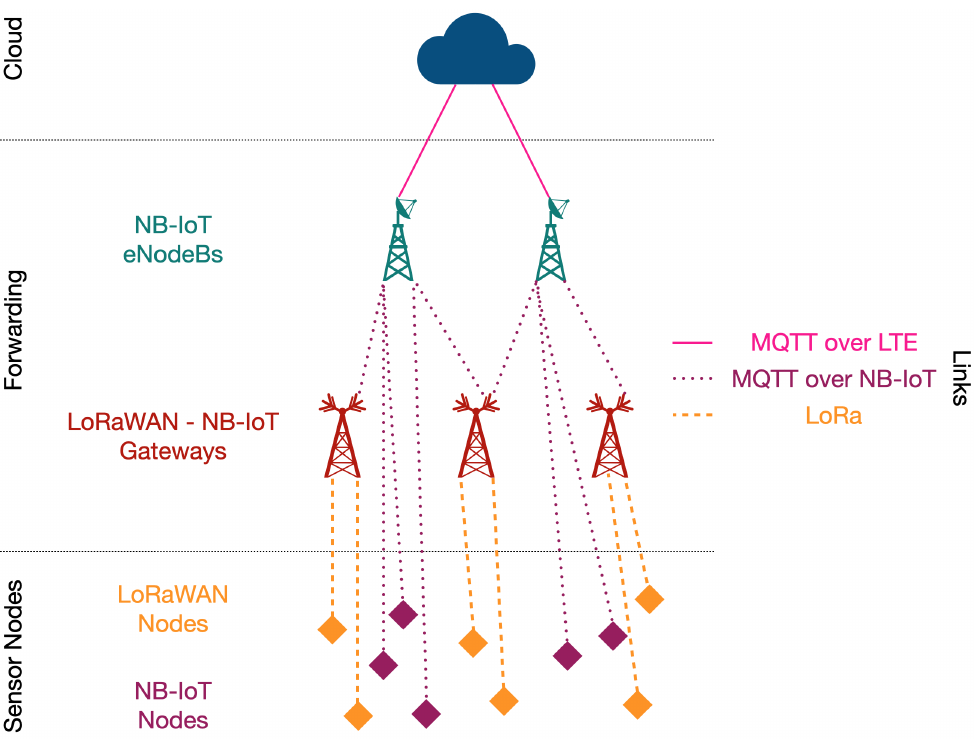
Figure 1. Network architecture